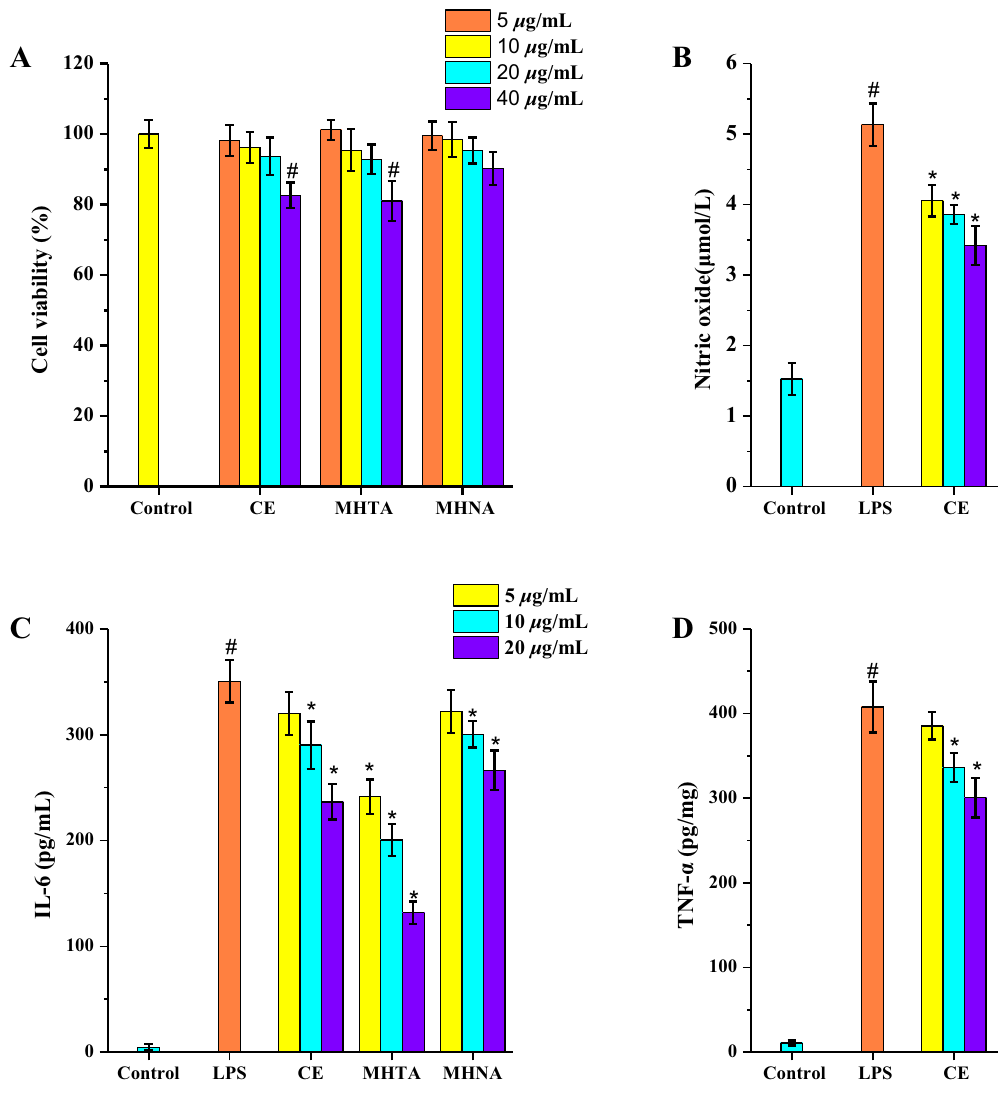
Fig. 1 a Effects of CE, MHTA and MHNA on the viability of RAW264.7 cells; b effects of CE, MHTA and MHNA on nitric oxide production of RAW264.7 cells; The effects of CE, MHTA and MHNA on inflammatory cytokines of RAW264.7 cells, c IL-6; D: